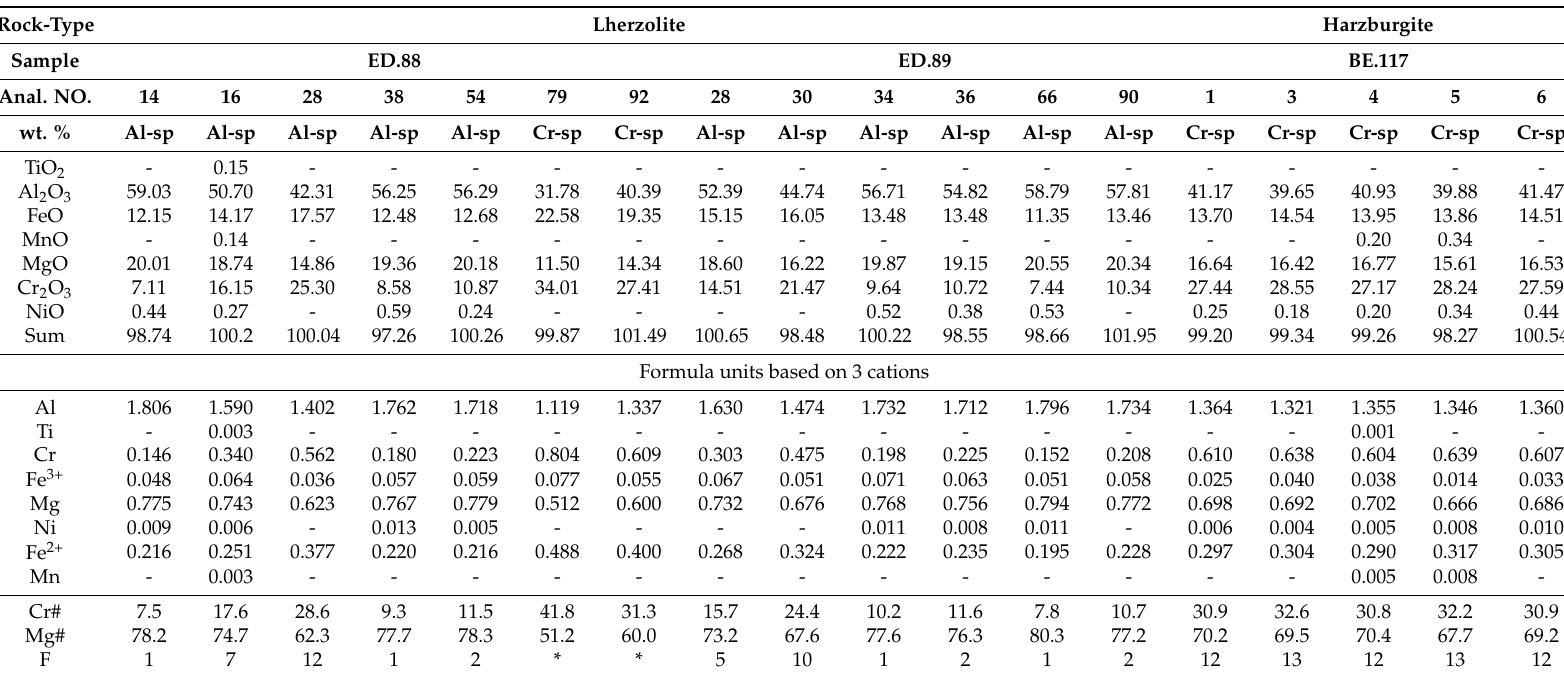
Table 1. Representative electron microanalyses of spinel-group minerals from peridotites of the Edessa ophiolitic complex (-: below detection limit; *: degrees F of partial melting are not calculated for altered and chemically modified